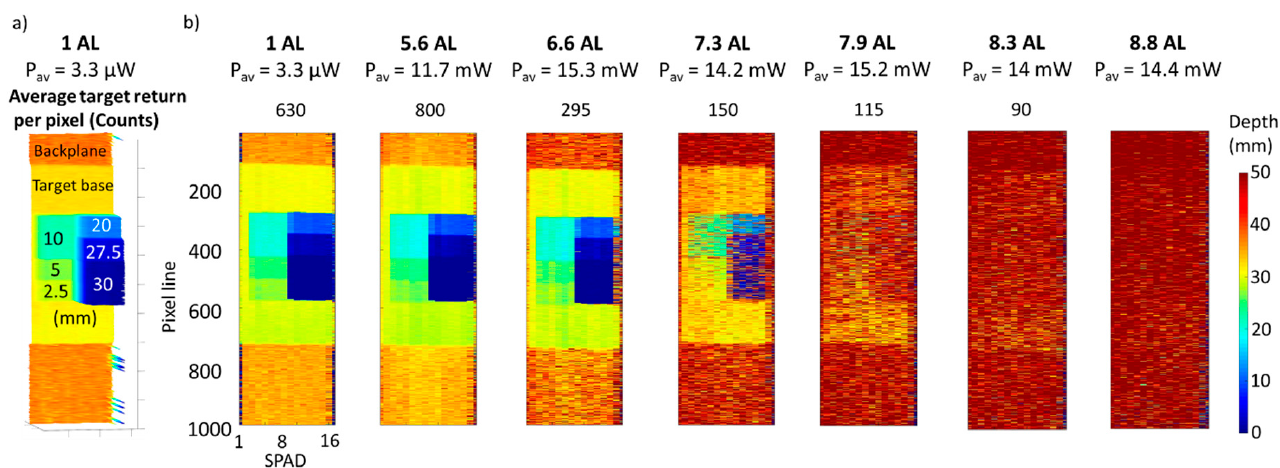
Figure 6. ( a ) Depth profile of the depth target in unfiltered tap water, equivalent to 1 AL between the system and the target. The figure shows the height of each block in mm with respect to the base of the target. ( b ) Depth profiles of the depth resolution target in unfiltered tap water and several concentrations of scattering agent. The data were analyzed with the pixel-wise cross-correlation approach, the acquisition time per line was set to 10 ms, and the average optical power was adjusted from 3.3 µ W to 15.3 mW, depending on the level of scattering in water. The average target return per pixel was calculated over the entire array for each scan, from line 200 to 600, using an acquisition time of 10 ms.